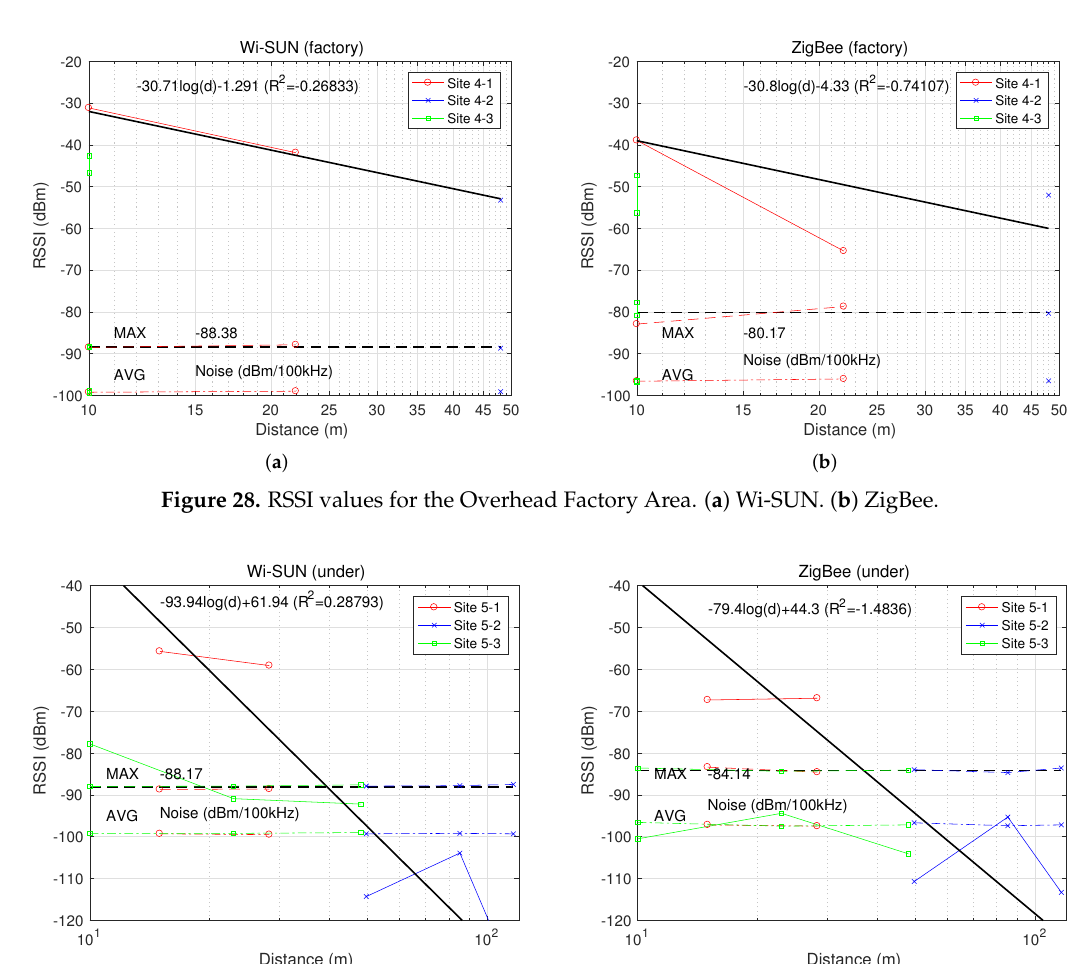
10 1 10 2 Distance (m) Figure 29. RSSI values for the Underground Area. ( a ) Wi-SUN modem. ( b )